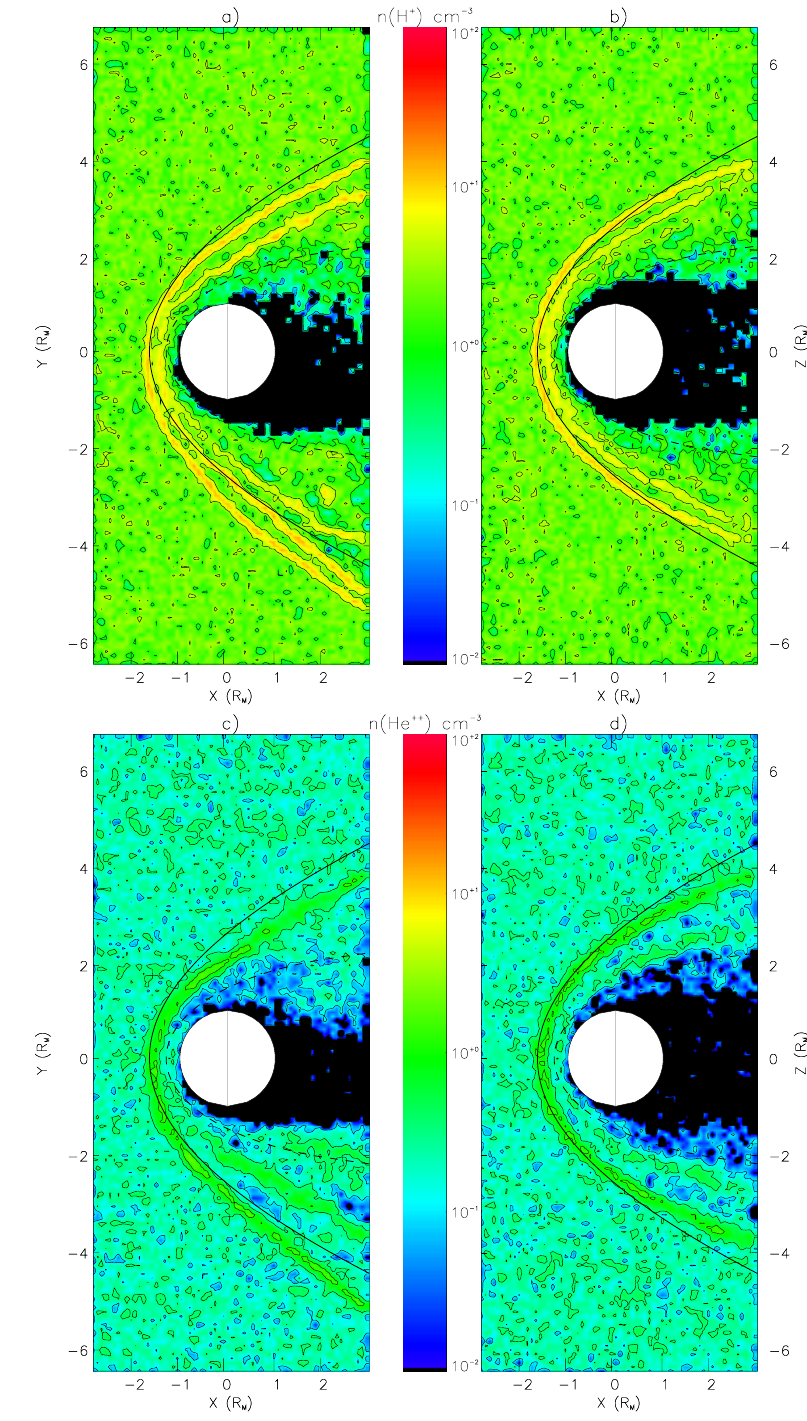
Fig. 3. Density maps of the solar wind ions. Top plates: Densities of the solar wind protons, left plate in the XY plane containing the motional electric field of the solar wind, right plate in the XZ plane containing the IMF. Bottom plates: Densities of the solar wind alpha particles in the same planes. The number density of alpha particles in the unperturbed upstream solar wind is equal to 5% of the proton number density. The solid and dashed black curves overlayed represent fits to the observations made by MGS, respectively, for the bow shock and the MPB (Vignes et al.,